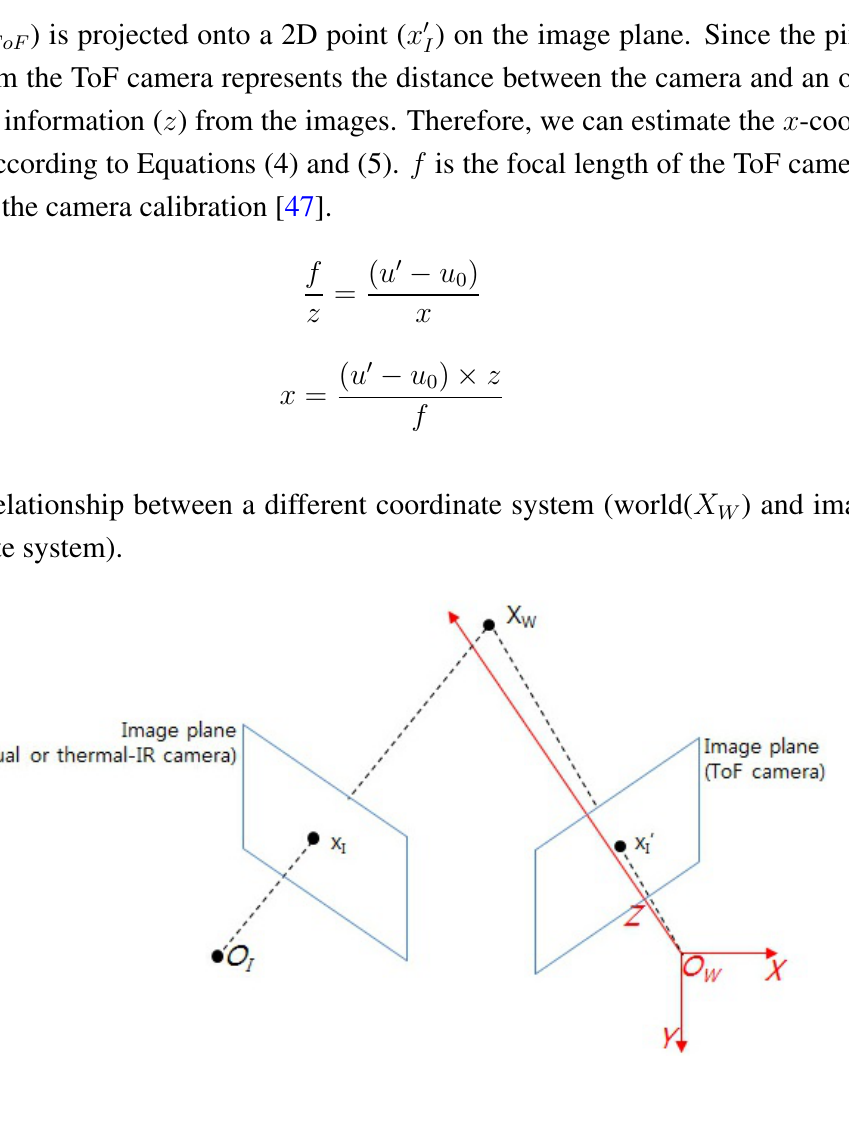
) is projected on a 2D point ( x (cid:48) ToF